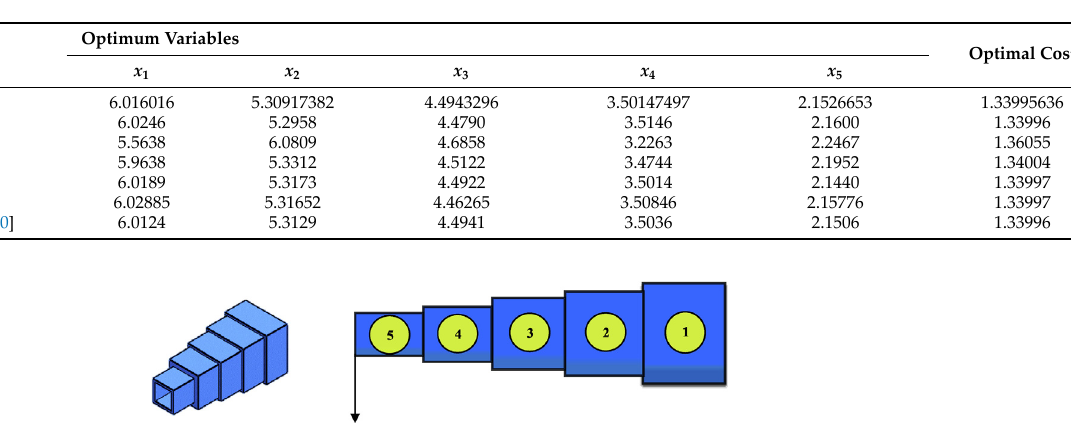
Table 9. Comparison of results of the cantilever beam problem.